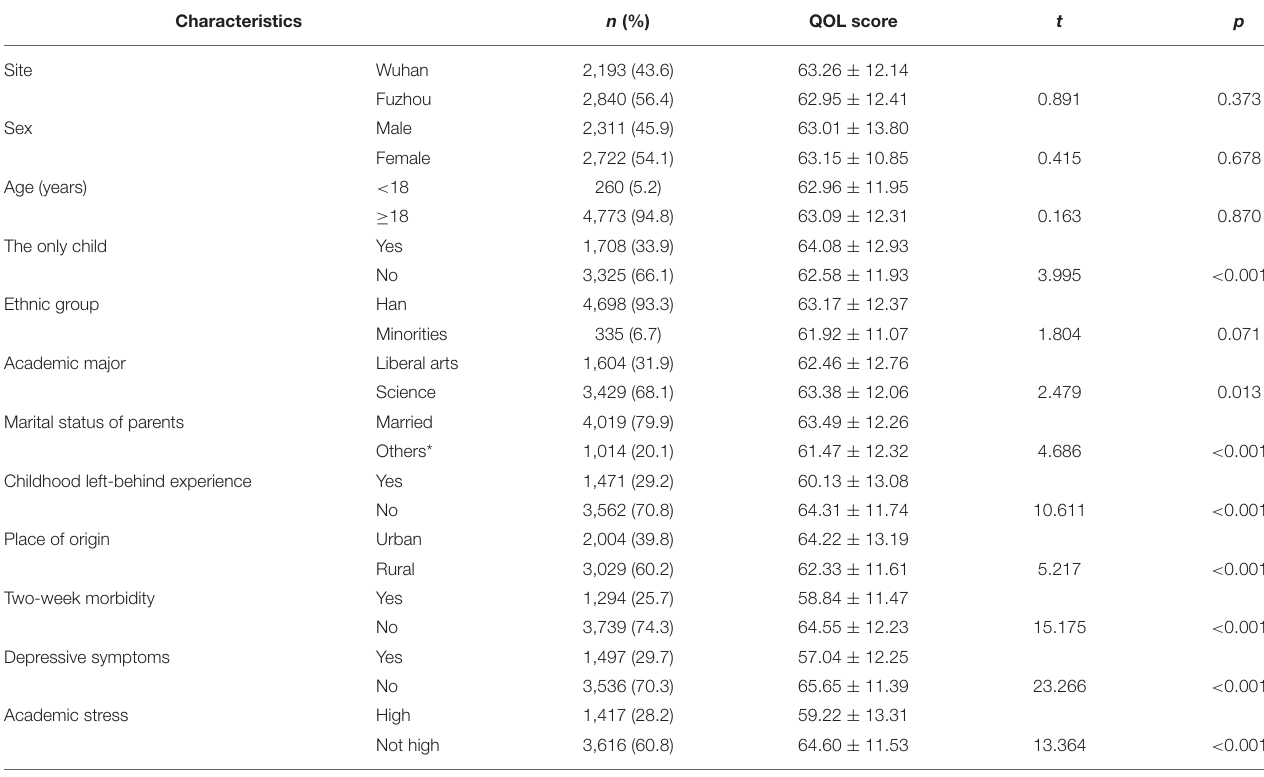
TABLE 1 | Characteristics of freshmen and quality of life (QOL) scores of different groups.